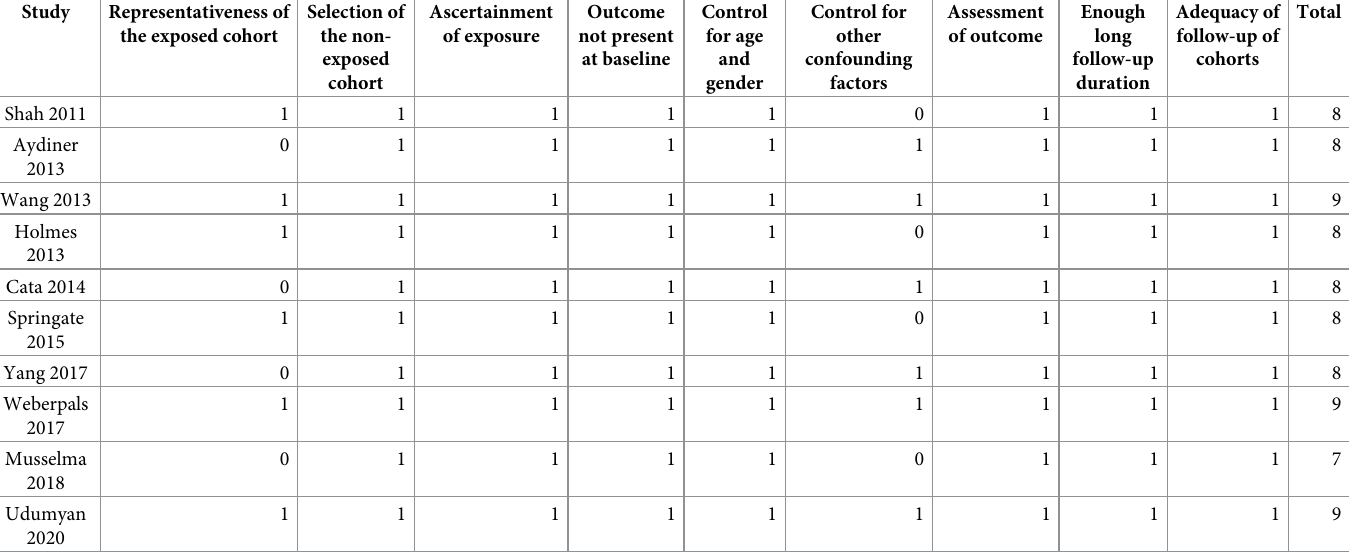
Table 2. Details of quality evaluation for the included studies via the Newcastle-Ottawa Scale.